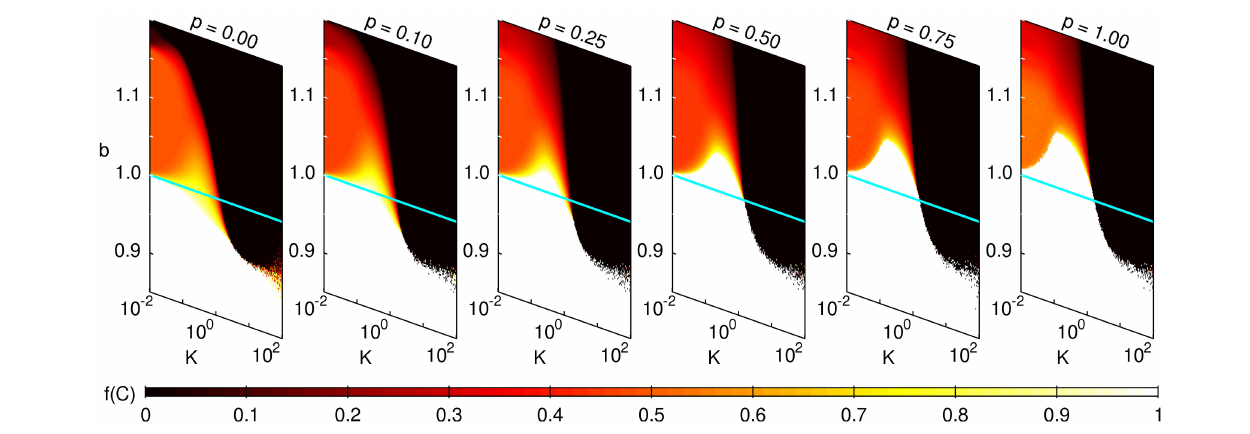
FIGURE 3 | Phase diagrams for the fraction of cooperators on a network of size N temptation payoff b and noise K , for different values of the rewiring parameter p . The initial fraction of cooperators is 0.5. The color indicates the fraction of cooperators ( f ( C ), whose value is indicated in the colorbar) in the system after 10 4 iterations, with white corresponding to the case of all C ( f ( C ) ( f ( C ) 0). The blue horizontal line in each panel indicates b = that a dynamical state corresponding to all C can only be achieved if b < 1, i.e., in the SH regime, while in the PD regime, this scenario will only emerge for larger p . The phase diagrams are constructed from single realizations of the dynamics for a given set of parameter